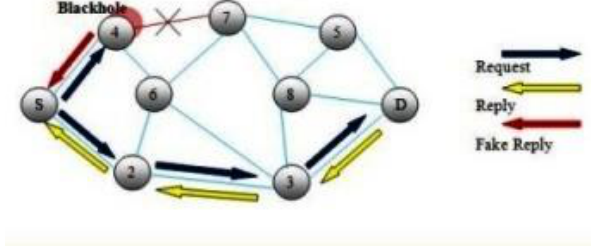
Figure 2: Black hole attack